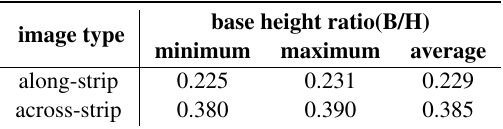
Table 5. Base height ratio for the testing